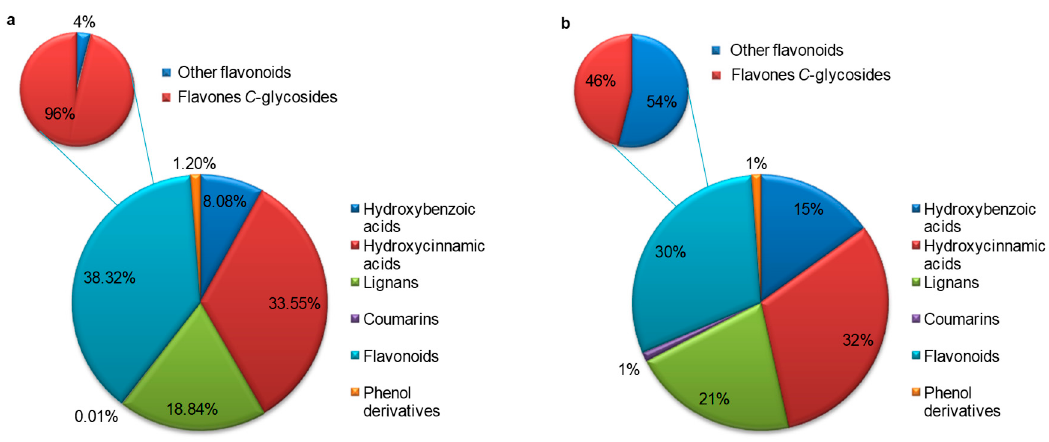
Figure 4. Summary of the characterization results on sesame phenolic compounds: ( a ) relative abundance (%) and ( b ) qualitative classification (%).